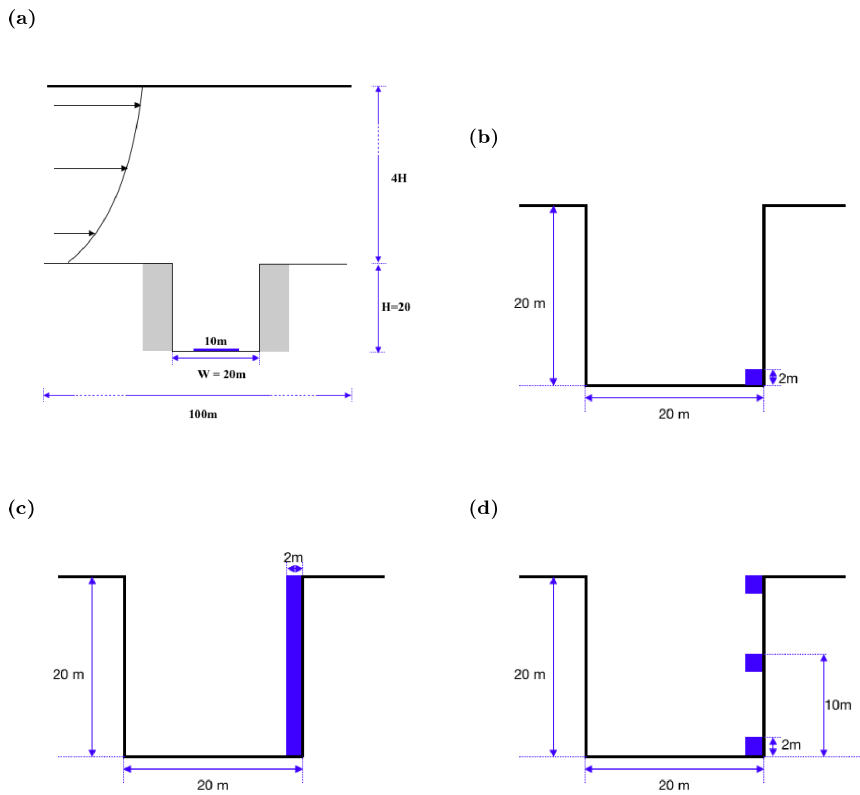
Figure 1. Schematic representations in the x – z plane (at the midplane y/W = 1) of the computational domain and pollutant sources: (a) ground-level traffic emissions; (b) near-ground cooking emissions; (c) column cooking emissions; (d) isolated cooking emissions. The emission scenarios are defined in Table 1. For clarity, the streamwise position of the cooking sources has been